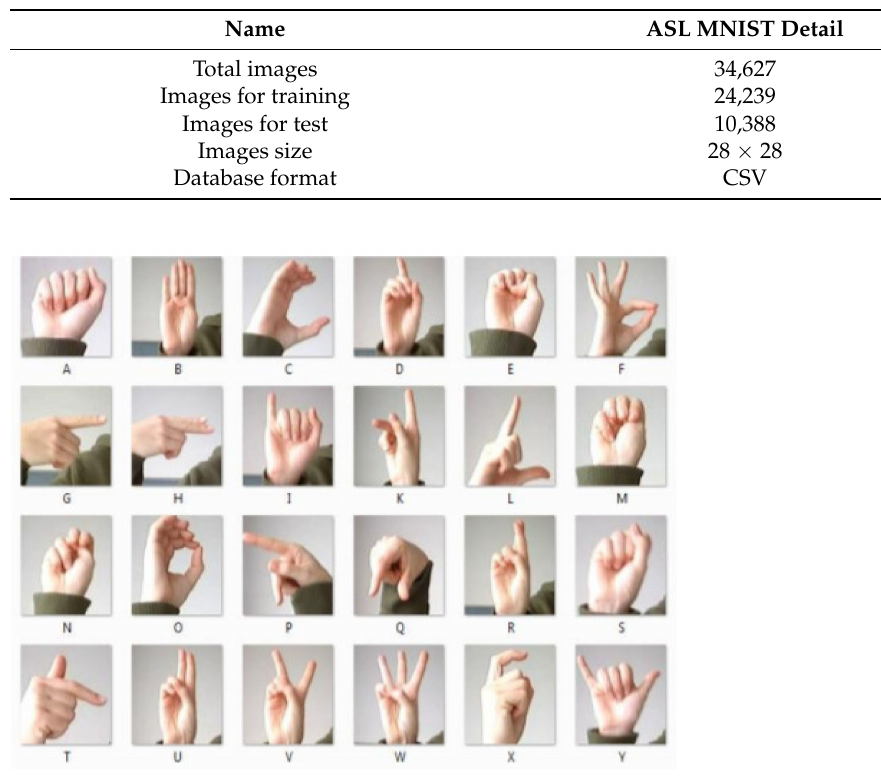
Table 6. ASL MNIST database description.